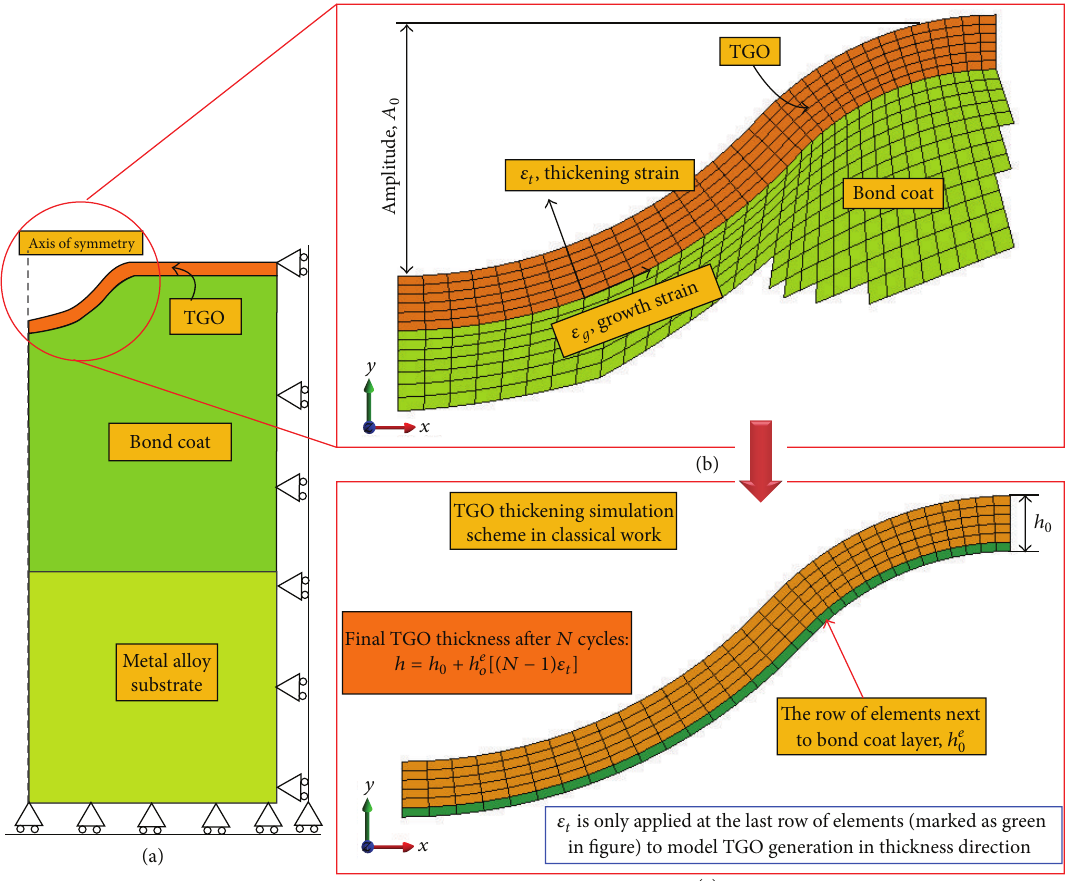
Figure 3: The FEM model used in the classical method. (a) The multilayer geometry model. (b) The mesh detailed in TGO layer. (c) The simulation strategy modeling TGO